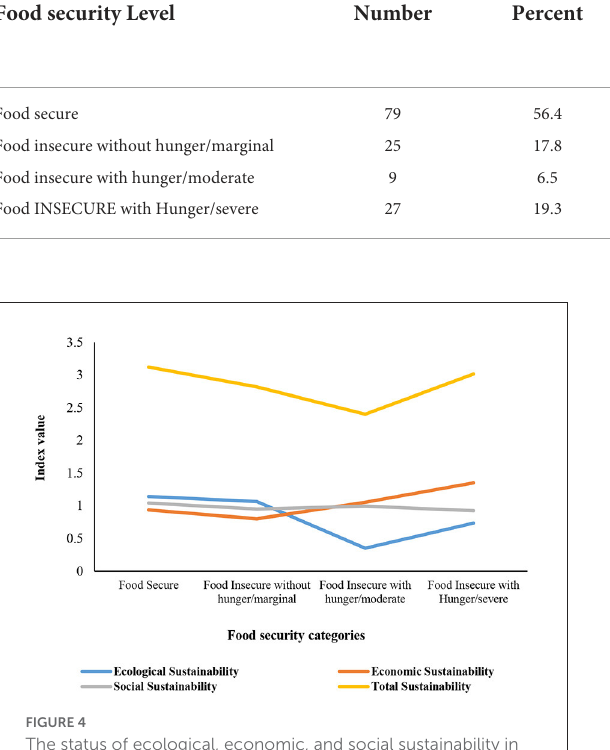
number of rooms, personal saving, and receiving a loan from a bank were significantly and inversely associated with food insecurity. The number of female and male children within a household, home area, age of home, distance from the city center, and receiving governmental support had a significant and direct association with food insecurity. The results demonstrated that none of the sustainability dimensions had a significant association with food